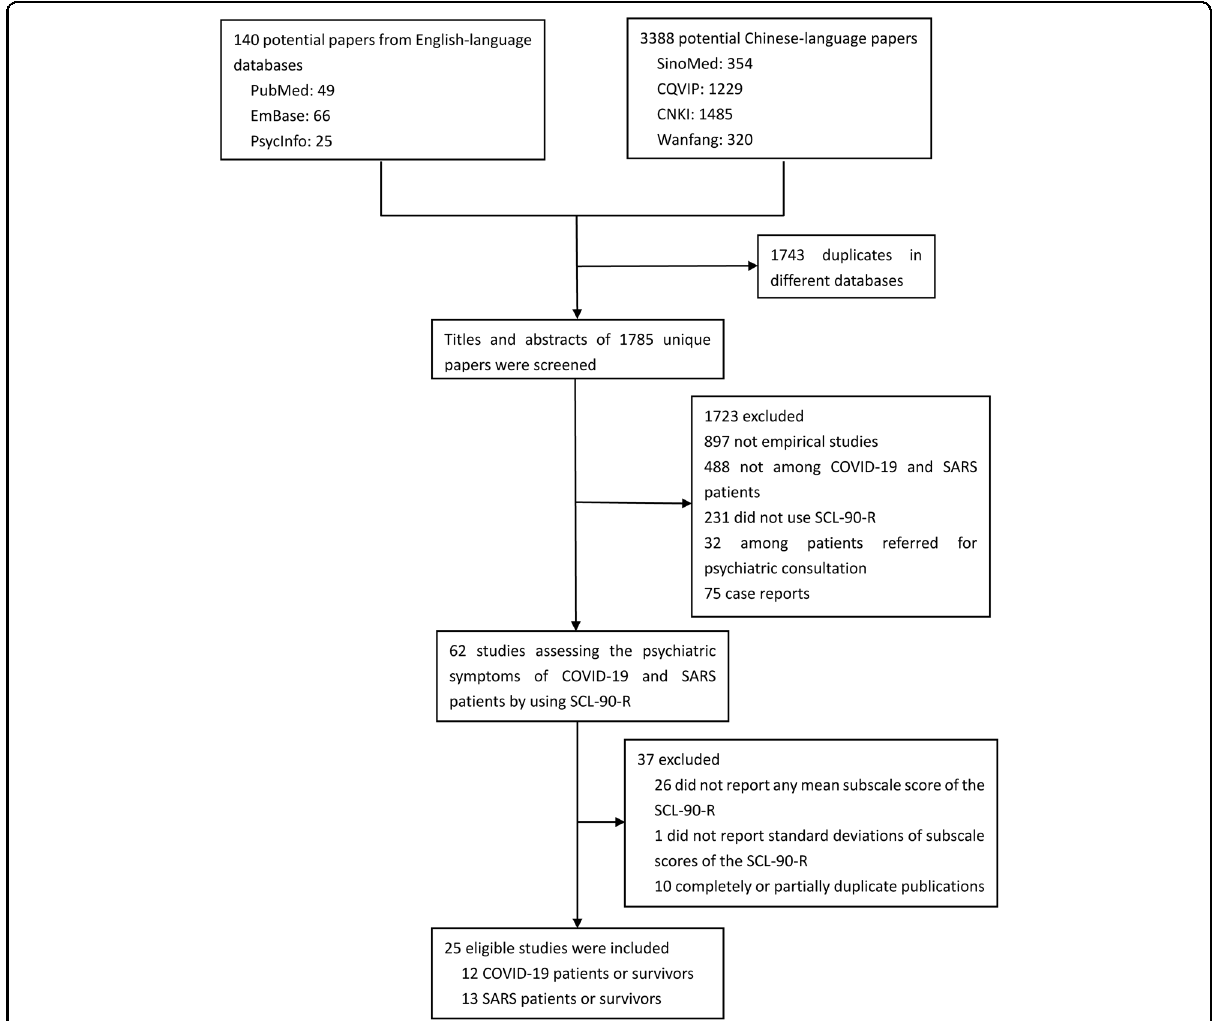
Fig. 1 Study identi fi cation and inclusion. Flowchart depicting the process of searching and screening for eligible studies of this